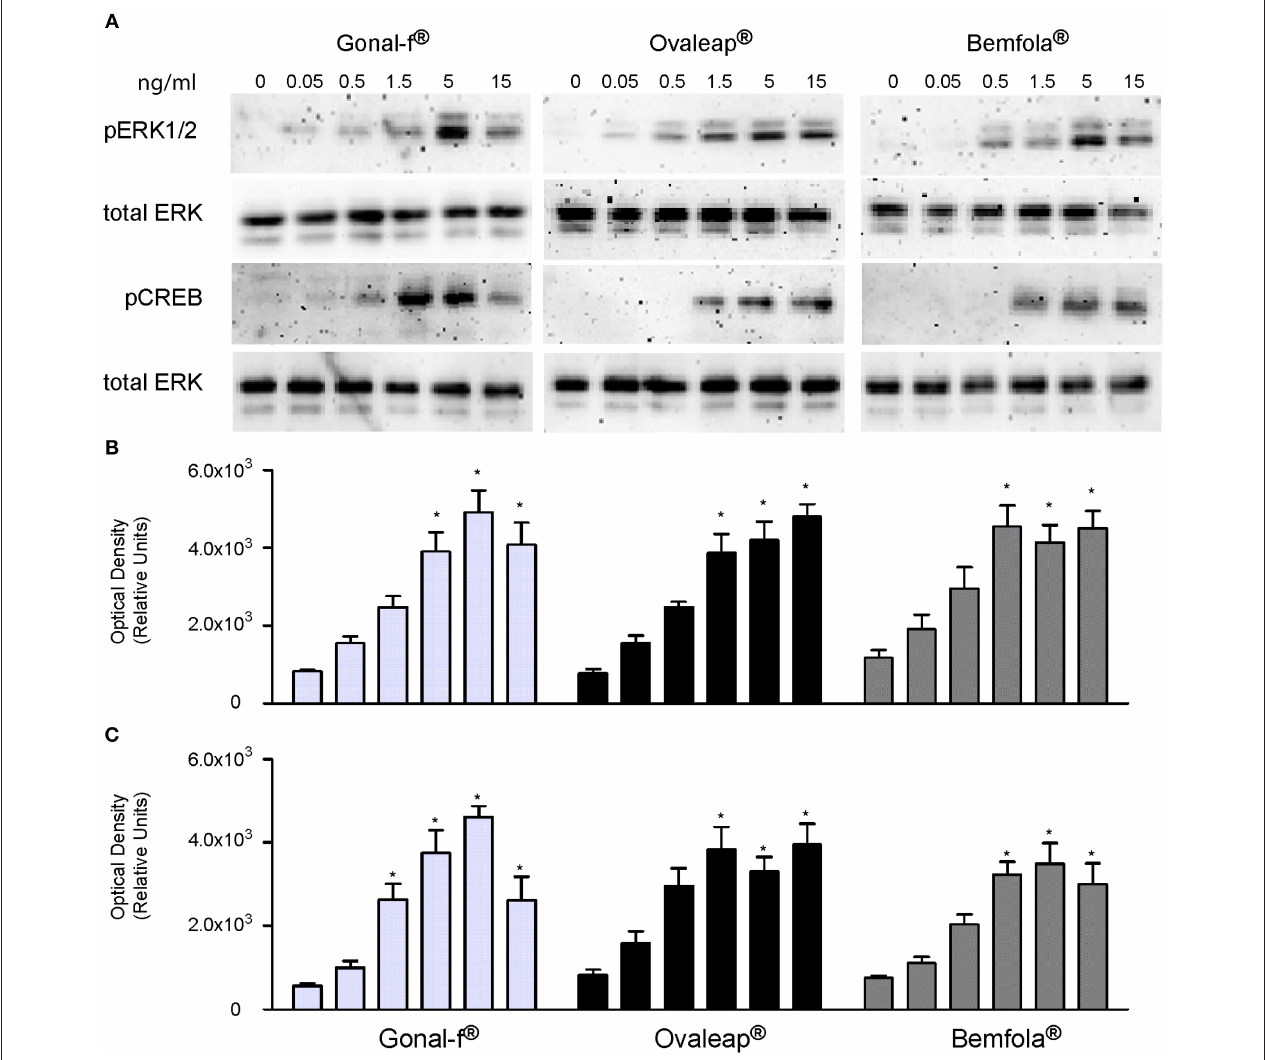
FIGURE 3 | Evaluation of pERK1/2 and pCREB activation after Gonal-f ® and biosimilars treatment of hGLC. Cells were stimulated by increasing doses of preparations. ERK1/2 and CREB phosphorylation were evaluated after 15min by Western blotting (images representative of four independent experiments) (A) . (B,C) Densitometric analysis of pERK1/2 (B) and pCREB (C) signals. The values were normalized to total ERK and represented as means ± SEM, then statistically evaluated (* = significant vs. control (0 dose); Kruskal Wallis test; p < 0.05; n = 4).